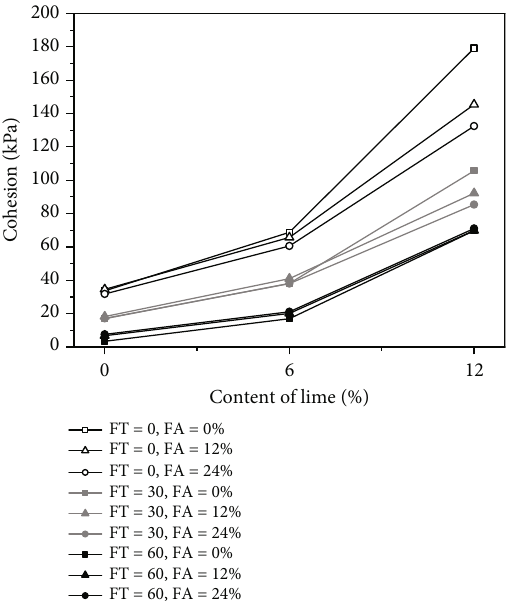
Figure 26: Cohesion at di ff erent lime contents.